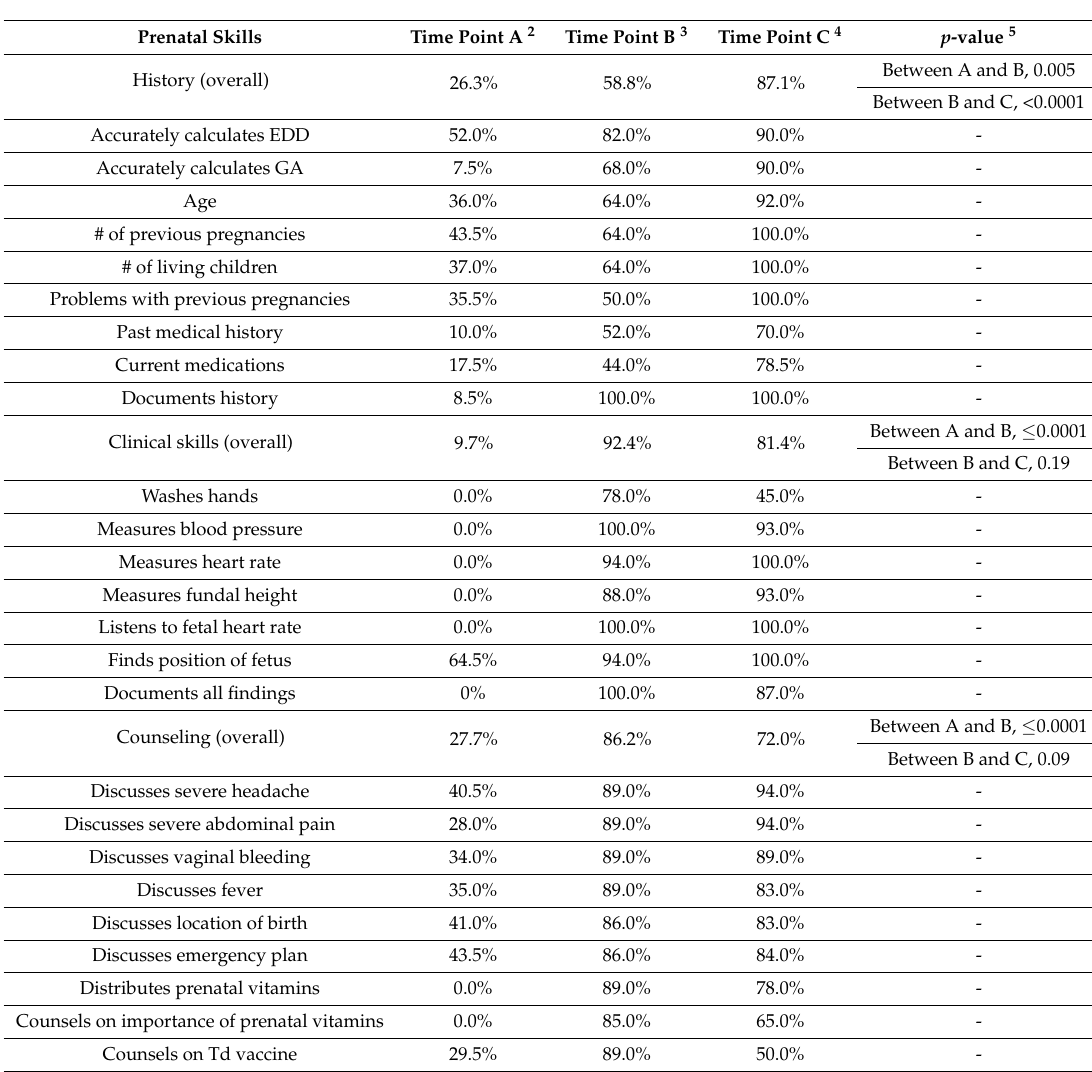
Table 5. The specific checklist improvements per category 1